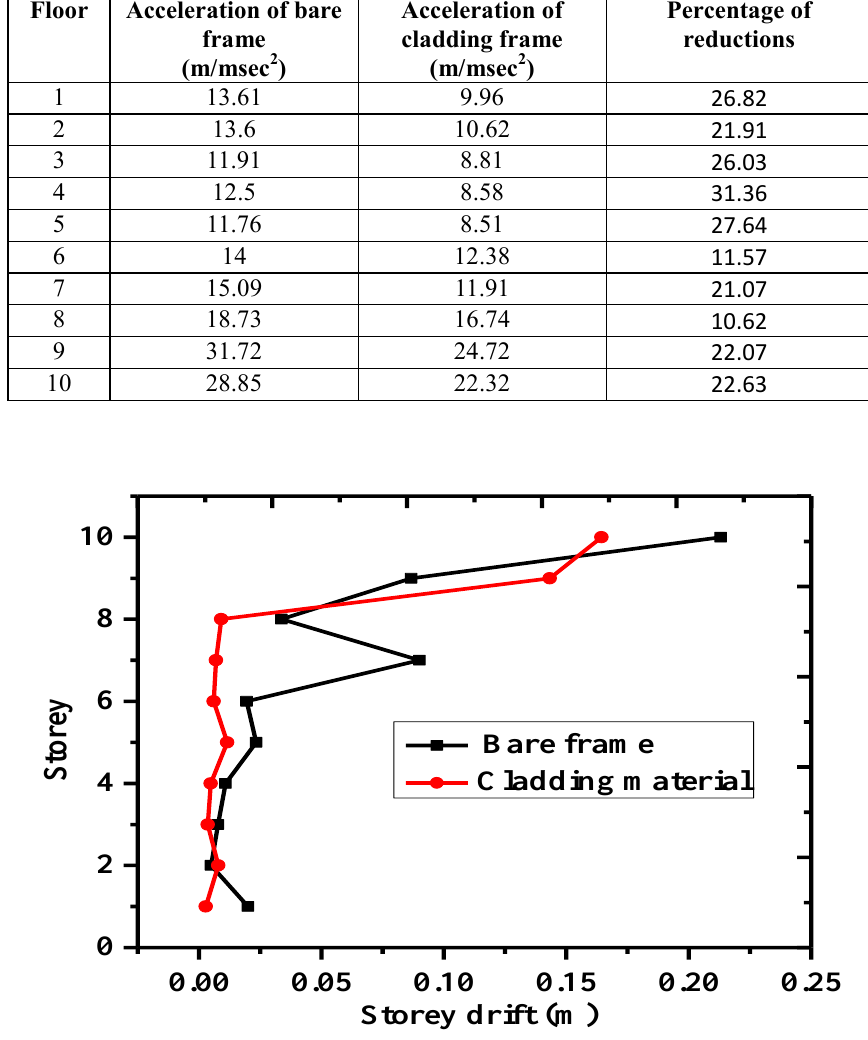
Fig. 6. Reduction of storey drift of 10 storey structure by cladding